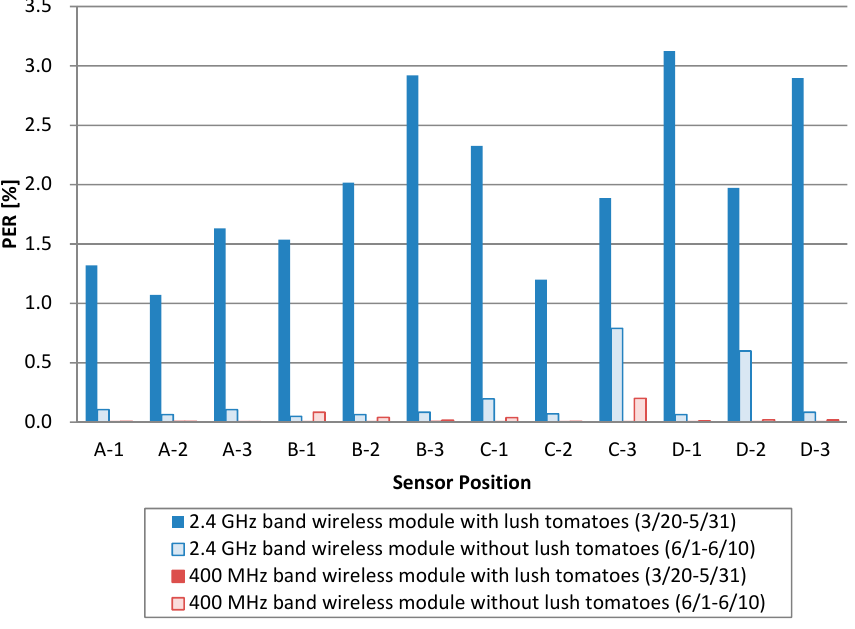
Figure 9. PER result for each sensor.